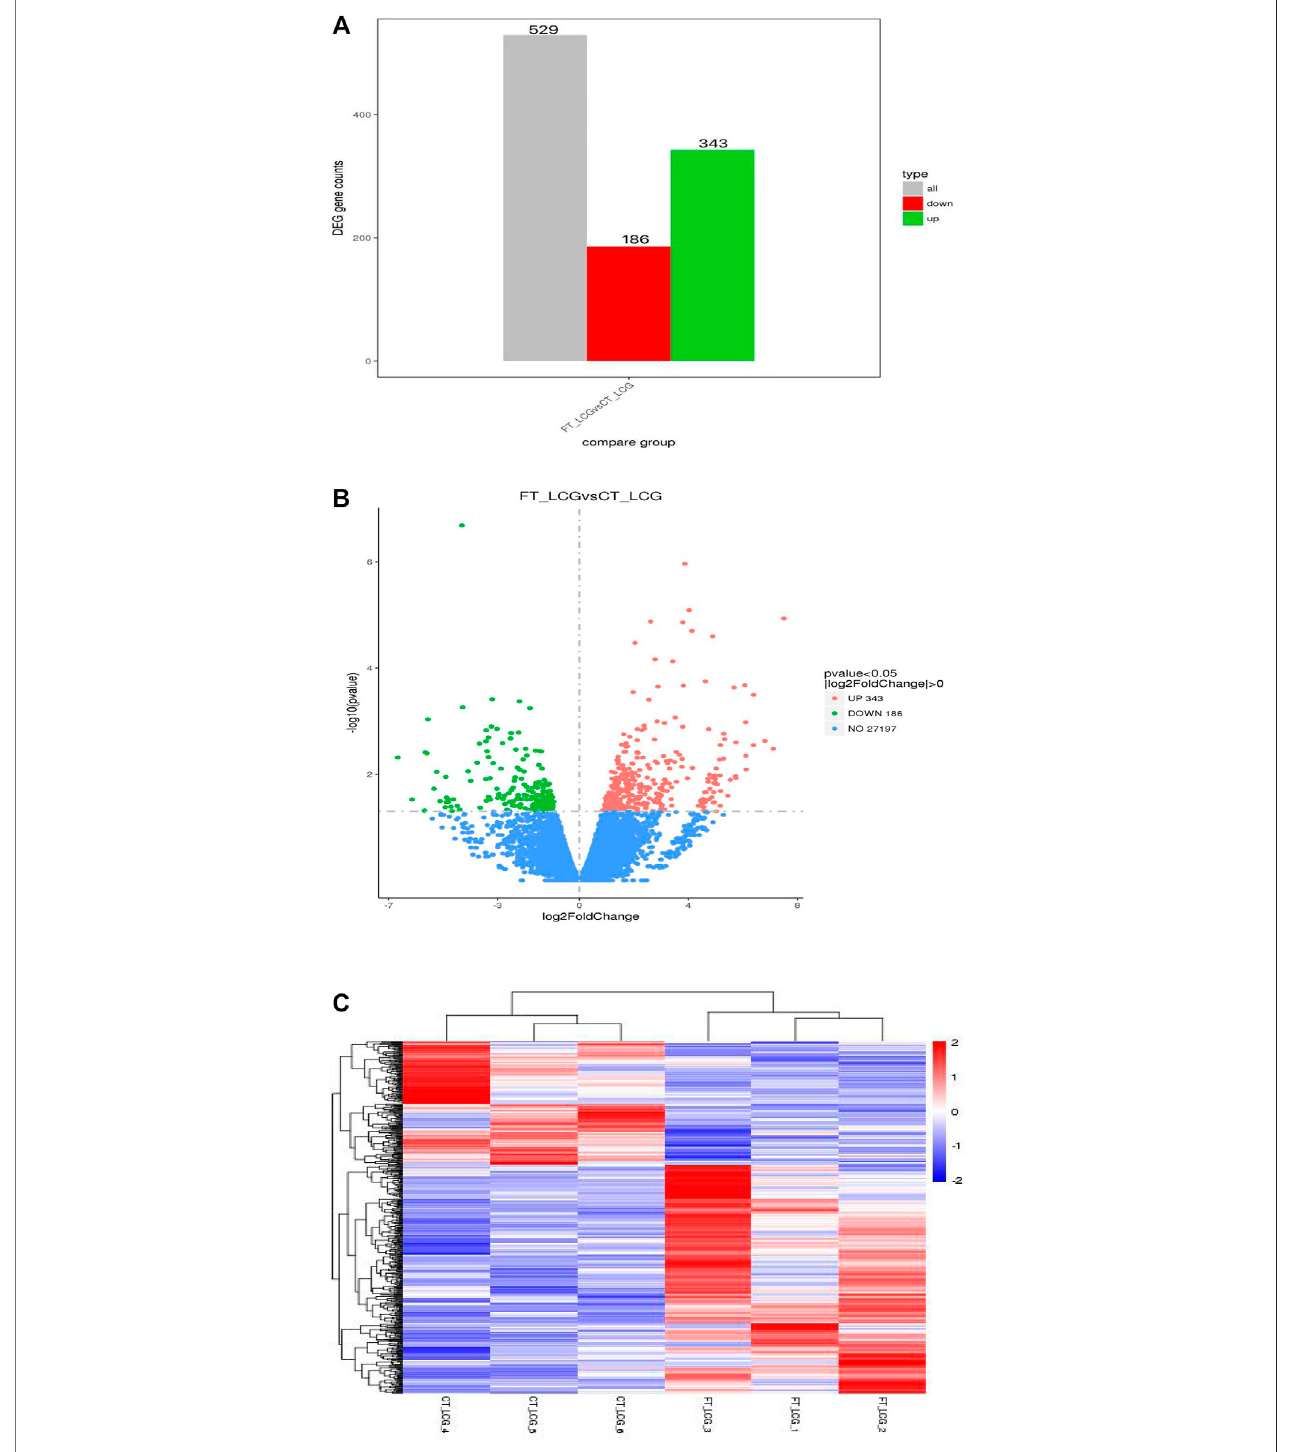
FIGURE4| Statistical chartofthenumberofdifferentgenesbetween fi netype and coarse type LCG. (A) Theabscissaofthehistogramisdivided intotwogroups: fi ne type and coarse type, the ordinate is the gene counts. (B) In the volcanic map, the abscissa represents the log2foldchange of gene expression in the treatment and controlgroups,andtheordinaterepresentsthesigni fi cantlevelofgeneexpressiondifferencebetweenthetreatmentandcontrolgroups,inwhichtheupregulatedgenes areindicatedbyreddotsandthedownregulatedgenesareindicatedbygreendots. (C) Geneexpressionclustermapof fi neandcoarsetypeLCG.Inthegraph,red indicates high gene expression and blue indicates low gene expression. The abscissa is the sample name, and the ordinate is the normalized value of RPKM.